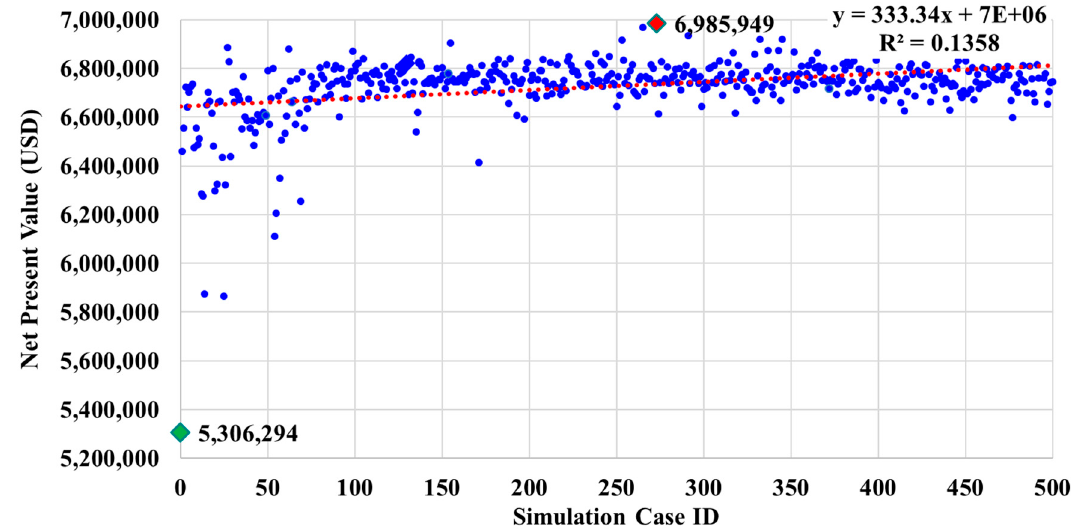
Figure 4. OCD’s optimization results (short ‐ term).